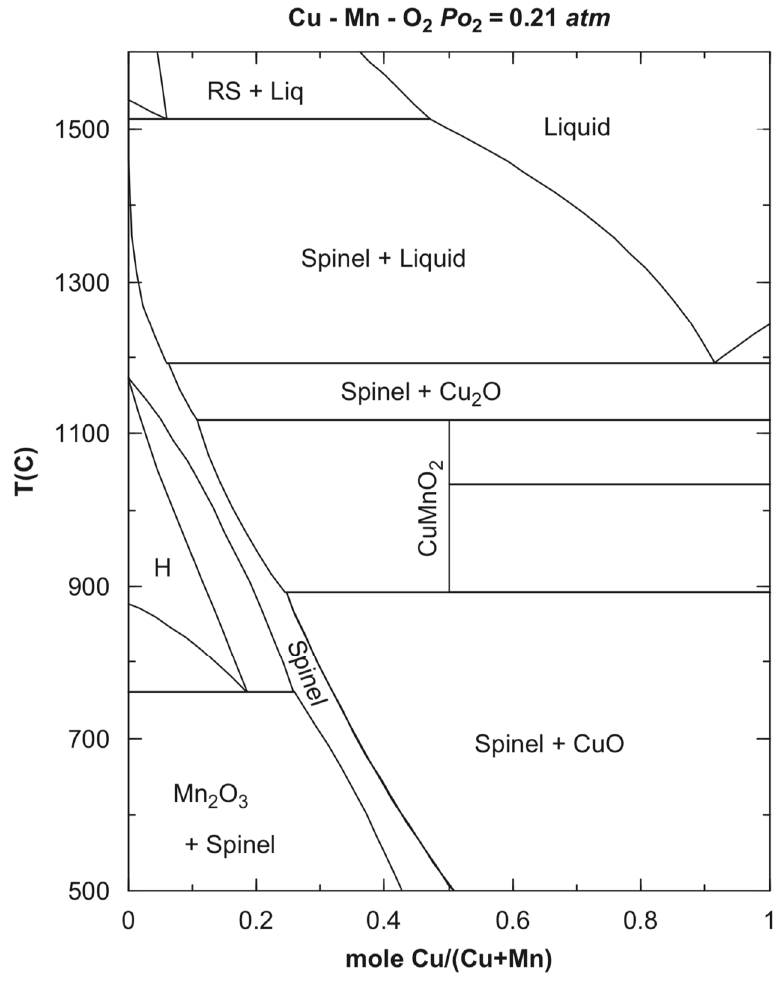
Figure 1. The calculated phase diagram of the Cu–Mn–O 2 system (reproduced from